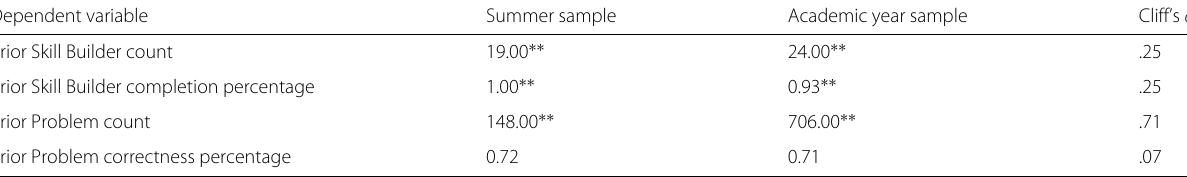
Table 8 Medians and effect sizes of prior-performance-based dependent variables for both sample populations